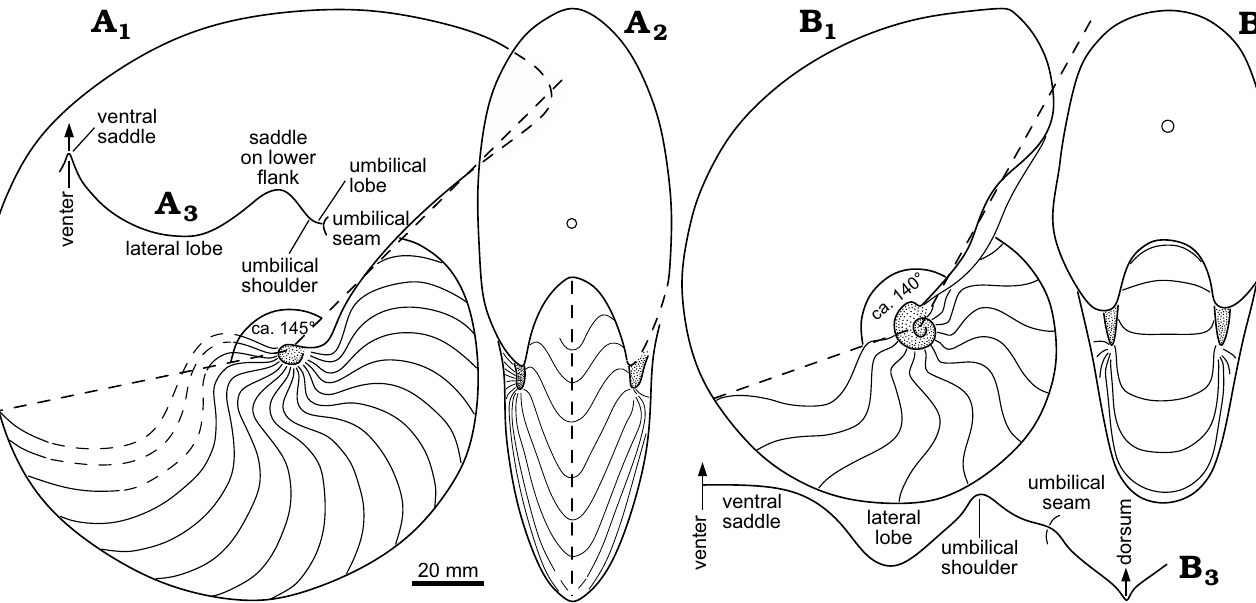
Fig. 12. Comparison of whorl sections, position of siphuncles, sutural sinuosity, and septal spacing of Angulithes mermeti (Coquand, 1862) (A) and a specimen illustrated as Nautilus pompilius Linnaeus, 1758 in the Treatise (Kummel 1964: fig. 329) (B). A . AFK 225 from the upper Cenomanian of Egypt in lateral (A 1 ) and apertural (A 2 ) views; external suture (A 3 ). B . Specimen from Tagnan (Philippines) at D = 130 mm from the SW Pacific (drawn from an artificial internal mould) (B 1 , B 2 ); suture line (B 3 ) (modified from Wani et al.